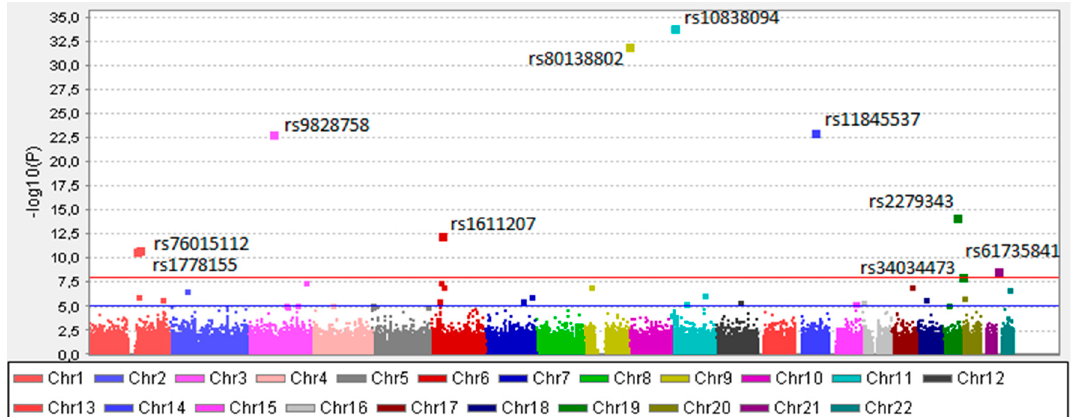
Figure 1. The “Manhattan” plot for the genome-wide association study of all analyzed mastocytosis patients. On the x-axis, each color represents different chromosomes. The log 10 of the unadjusted p -values (without multiple testing corrections) are shown at the y-axis. The blue line indicates the suggestive association threshold (10 − 5 ), while red line indicates GWAS significant threshold (10 − 8 ).